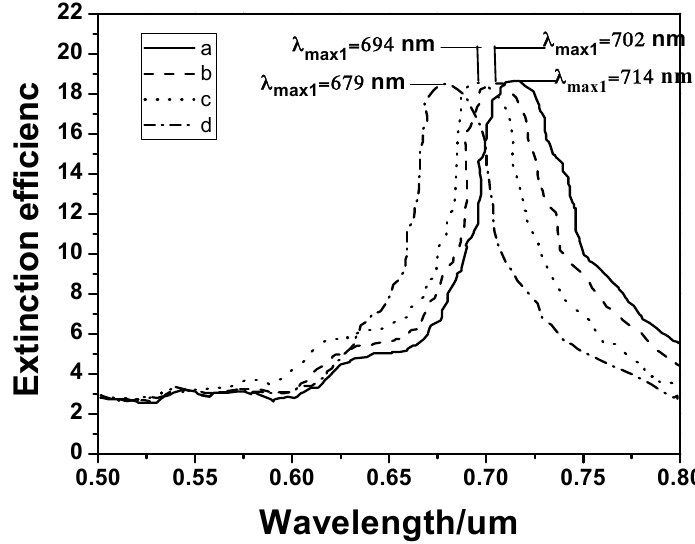
Figure 12. LSPR spectra of the SH- β -CDs-modified hybrid Au–Ag hexagonal lattice of triangular PNAs as a function of PCB-77 concentration: ( a ) 1 × 10 − 5 g/mL; ( b ) 1 × 10 − 6 g/mL; ( c ) 1 × 10 − 7 g/mL; and ( d ) 1 × 10 − 8 g/mL.